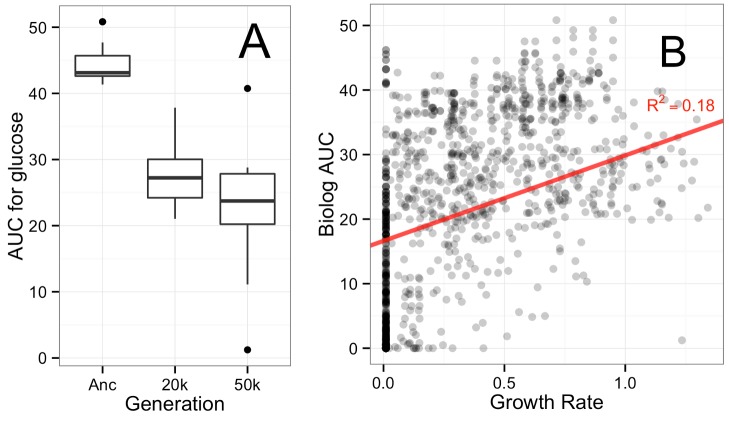
Biolog measurements are a poor proxy for growth performance.(A) Biolog AUC as measured for the D-glucose on Biolog plates. The evolved strains have a lower AUC value than the ancestor on glucose, the carbon source available during evolution (p<0.0001, Welch's two sample t test). The mean AUC for the 20k and 50k isolates on glucose are not statistically different. (B) Scatter plot showing the measurement of function as Biolog AUC versus growth rate on all substrates, for all strains at 20k and 50k generations as well as the ancestors. The regression shown is for substrates after removal of categorical disagreements (growth without respiration or respiration without growth, 167/702 in total).